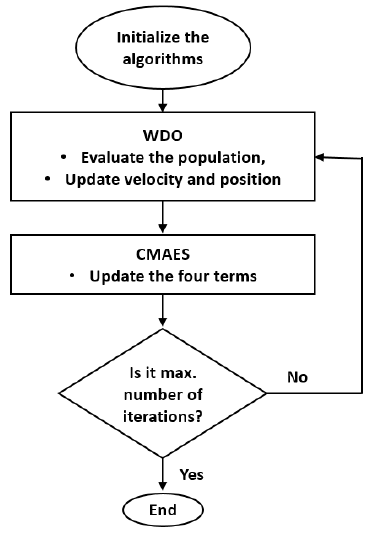
Table 2. Results of Sphere in search space of [-100, 100] N=10